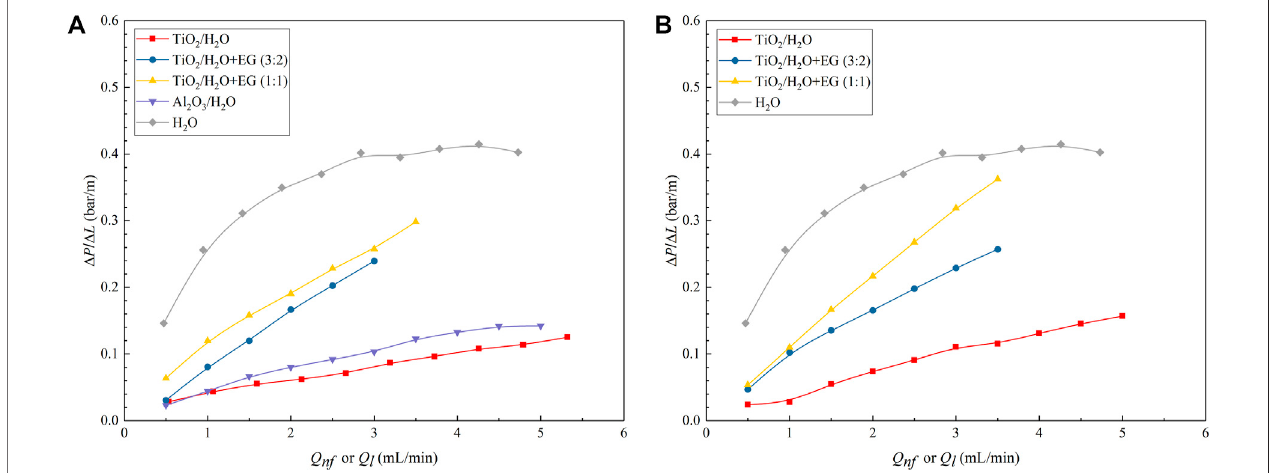
FIGURE 10 | Comparison between the measured pressure drop data under slug fl ows of N 2 -nano fl uid and N 2 -water in the 0.8-mm diameter microchannel. Q g (cid:1) 2.77 ml/min. (A) φ (cid:1) 0.05 vol%; (B) φ (cid:1) 0.15 vol%.